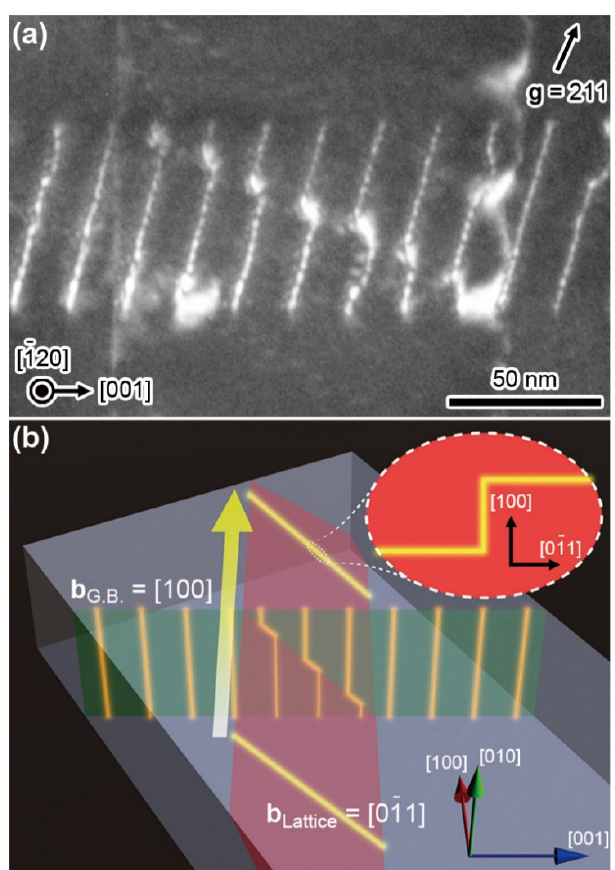
Figure 76. ( a ) A dark-field TEM image of the grain boundary edge dislocations after the nanoindentation experiment. It is clear that the grain boundary edge dislocation lines are shifted and the superjogs were formed on them; ( b ) Schematic illustration of the crossing process of the lattice screw dislocations. The intersection of the screw dislocation with the grain boundary edge dislocations forms the jogs on the grain boundary dislocations and the kinks on the lattice dislocation. Adapted with permission from Ref.